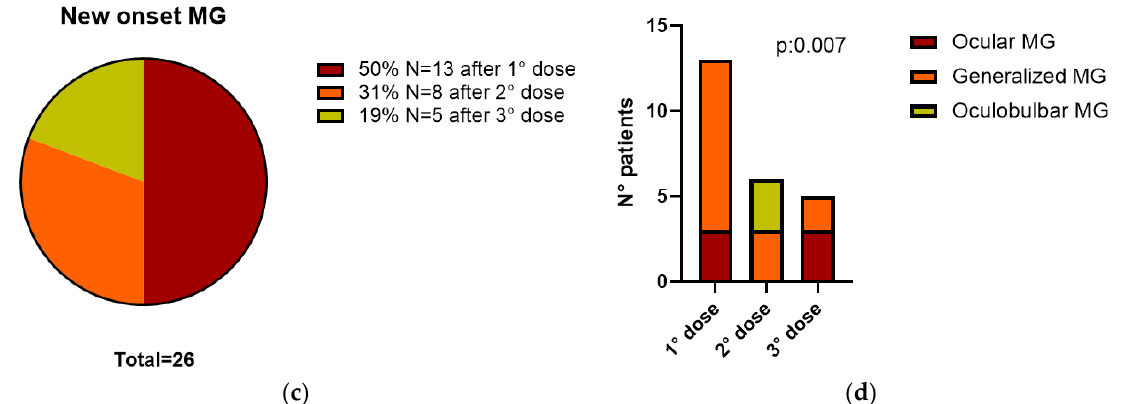
Figure 3. ( a ) Distribution of patients according to the age at MG onset and diagnosis. ( b ) In the literature, the majority of MG new diagnoses after COVID-19 vaccination occurred in males with higher age (* p < 0.05) at onset and diagnosis (LOMG). ( c ) Distribution of patients according to the dose of vaccine and onset of MG. ( d ) Stratification of patients based on the dose of immunization and type of MG. Resampling methods were not conducted. Abbreviations: MG: myasthenia gravis, LOMG: late-onset MG.